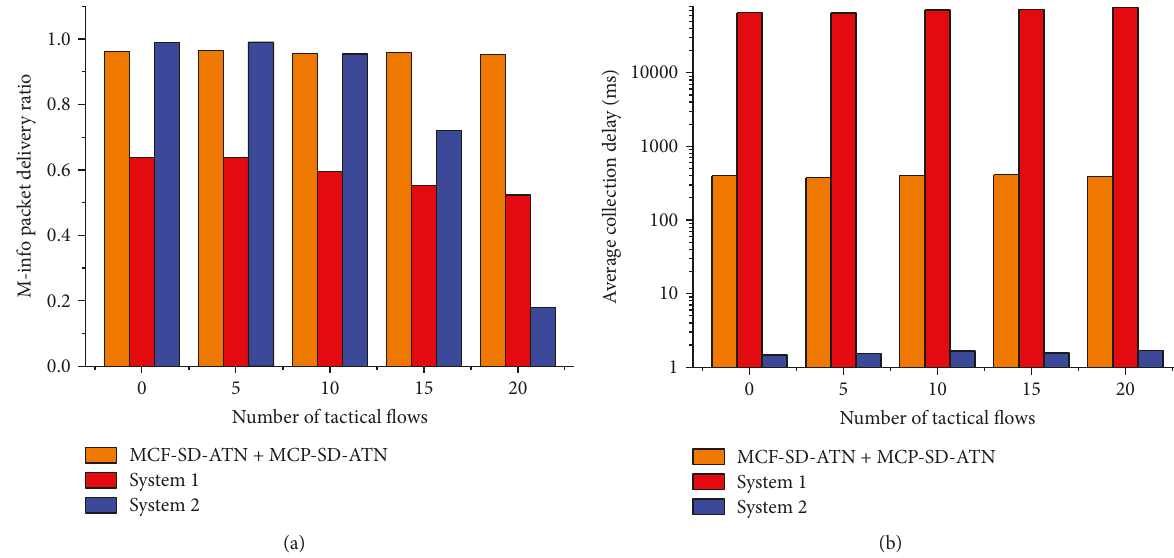
Figure 12: M-info collection performance of di ff erent communication schemes. (a) Performance of the M-info packet delivery ratio. (b) Performance of the average M-info collection